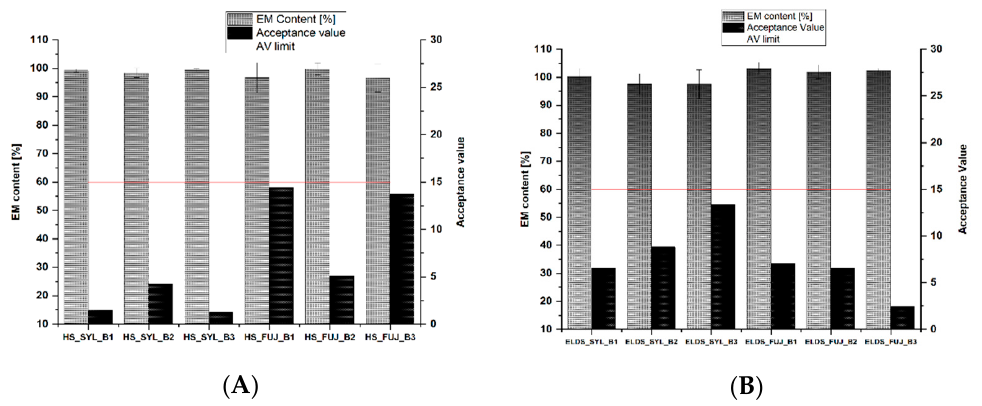
Figure 3. EM content (%) and acceptance value (AV) for 1 mg enalapril maleate capsules. ( A ) Manual capsule dosing using a Hamilton syringe, ( B ) capsule production with ELDS, x ± sd, n = 10. ( x -axis labelling: dosing system excipient batch, HS = Hamilton syringe, SYL = Syloid 244 FP, FUJ =